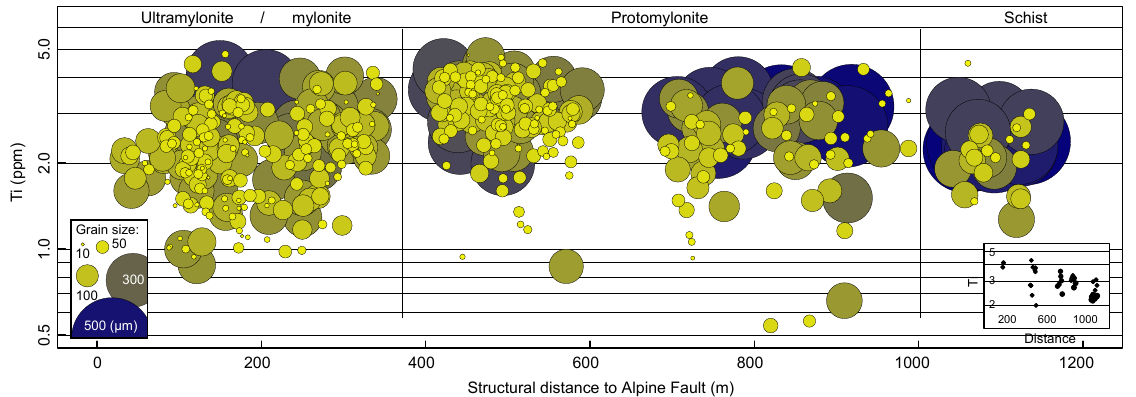
Figure 9. Ti concentrations vs. distance from the Alpine Fault for Gaunt Creek samples, with dot size indicating grain size. Small recrys- tallized grains ( < ∼ 300µm) near the fault are more likely to show decreased Ti concentrations than similar sized recrystallized grains away from the fault – this supports microstructural observations (e.g., Fig. 3) that lower Ti concentrations were stable during ultramylonite defor- mation but not during mylonite and protomylonite deformation. Inset shows that Ti concentration in the coarsest grains ( > 300µm) increases slightly towards the fault. The data are jittered along the x axis by an amount not exceeding 50km in order to increase visibility.